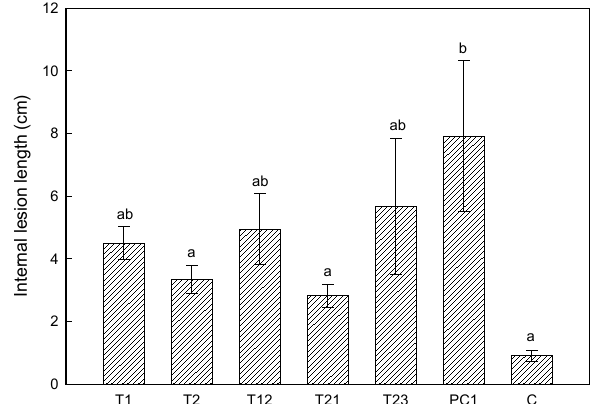
Figure 3. Mean internal lesion lengths (cm) on excised grapevine canes (cv. Grecanico) 15 d after inoculation with isolates of Neo- fusicoccum parvum (T1), Phaeoacremonium sp. (T2), Ilyonectria liriodendri (T12), Neonectria sp. (T21), Cadophora luteo - olivacea (T23), or Phaeomoniella chlamydospora (PC1), compared to non- inoculated controls (C). The vertical lines indicate standard errors. Bars accompanied by the same letter are not significantly different ( P < 0.05, Fisher’s LSD